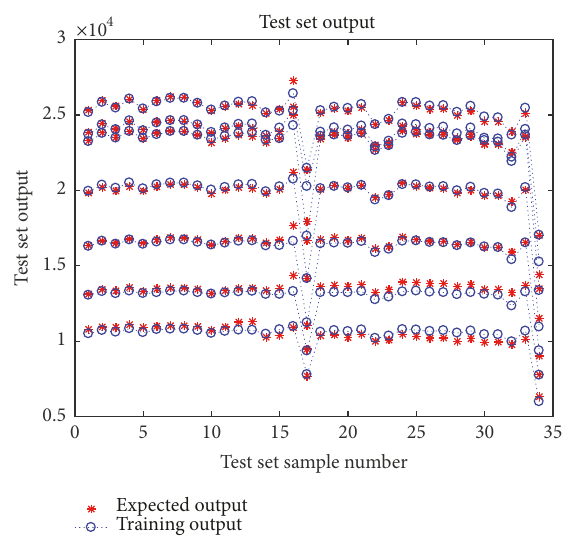
Figure 5: Prediction results of PSO-GA-MELM based rolling force prediction